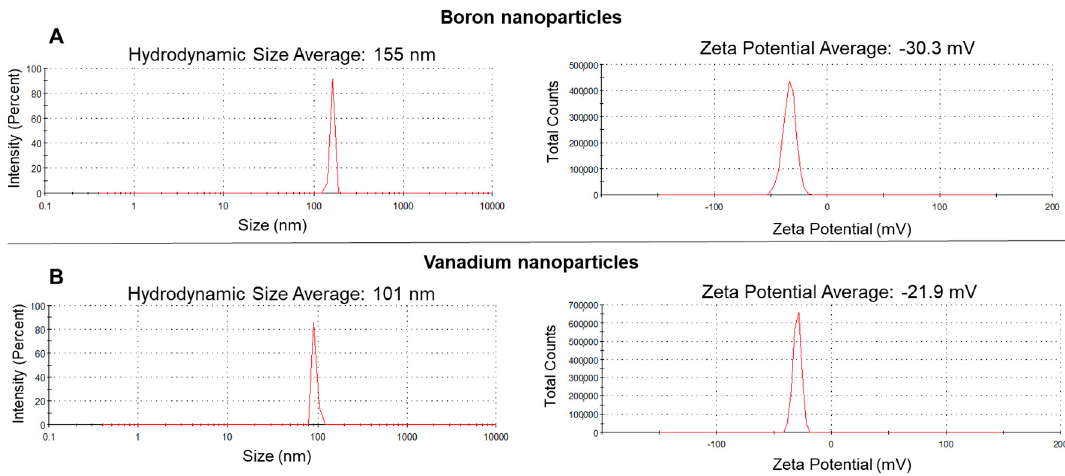
Figure 2. Hydrodynamic size assessed by dynamic light scattering and zeta potential evaluated by electrophoretic light scattering of boron nanoparticles ( A ) and vanadium nanoparticles ( B ) dispersions (at 0.02%, diluted in ultrapure water).